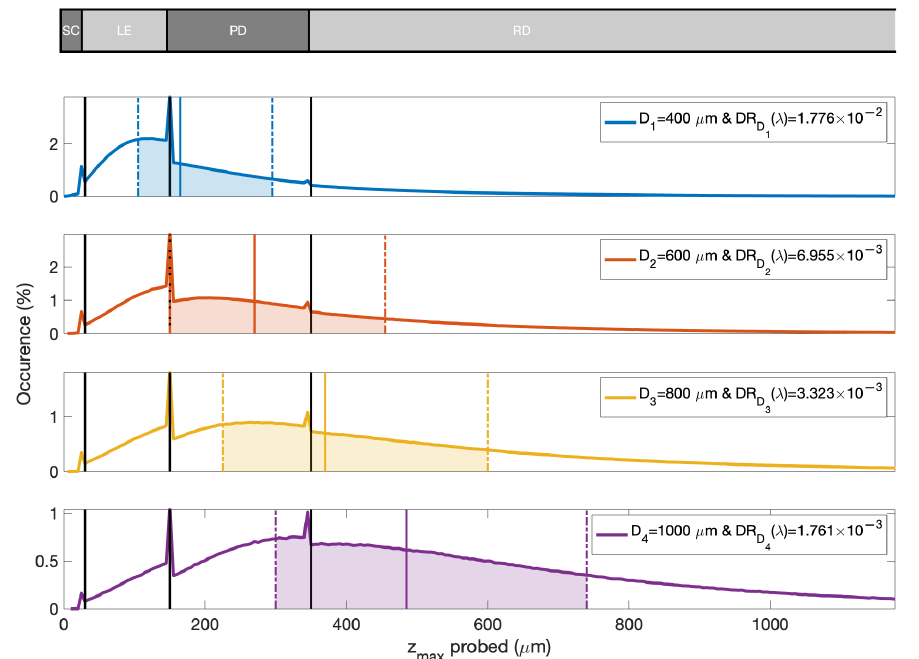
Figure 4. Normalized probed depth histograms of weighted detected DR photons at λ = 565 nm (central wavelength of the spectrum 365–765 nm) for the four SD distances. Vertical black lines represent the borders between layers. Colored vertical lines represent, from left to right, the first quartile (dashed-dot), the median (solid) and the third quartile (dashed-dot). The considered medium is the healthy skin model with intermediate thicknesses, phototype I and mean blood dermal